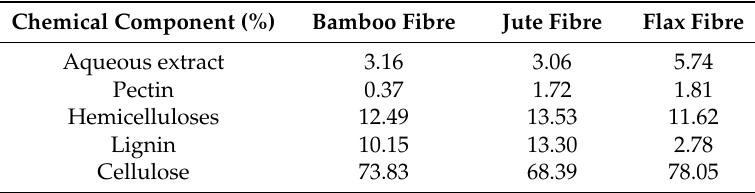
Table 4. Chemical components of different fibres